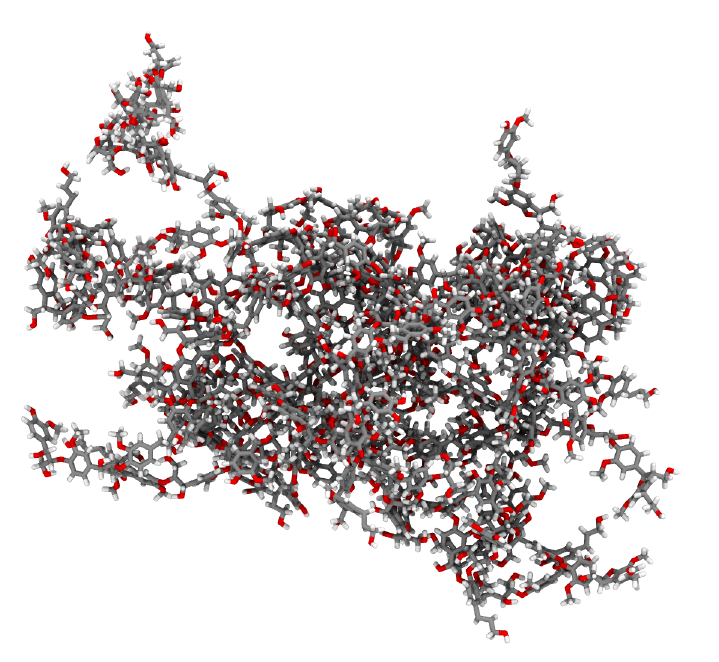
Figure 4. Initial structure for our example lignin polymer, featuring multiple aromatic ring piercings that must be resolved. In the shown representation, atoms are color coded, with gray for carbon, red for oxygen, and white for